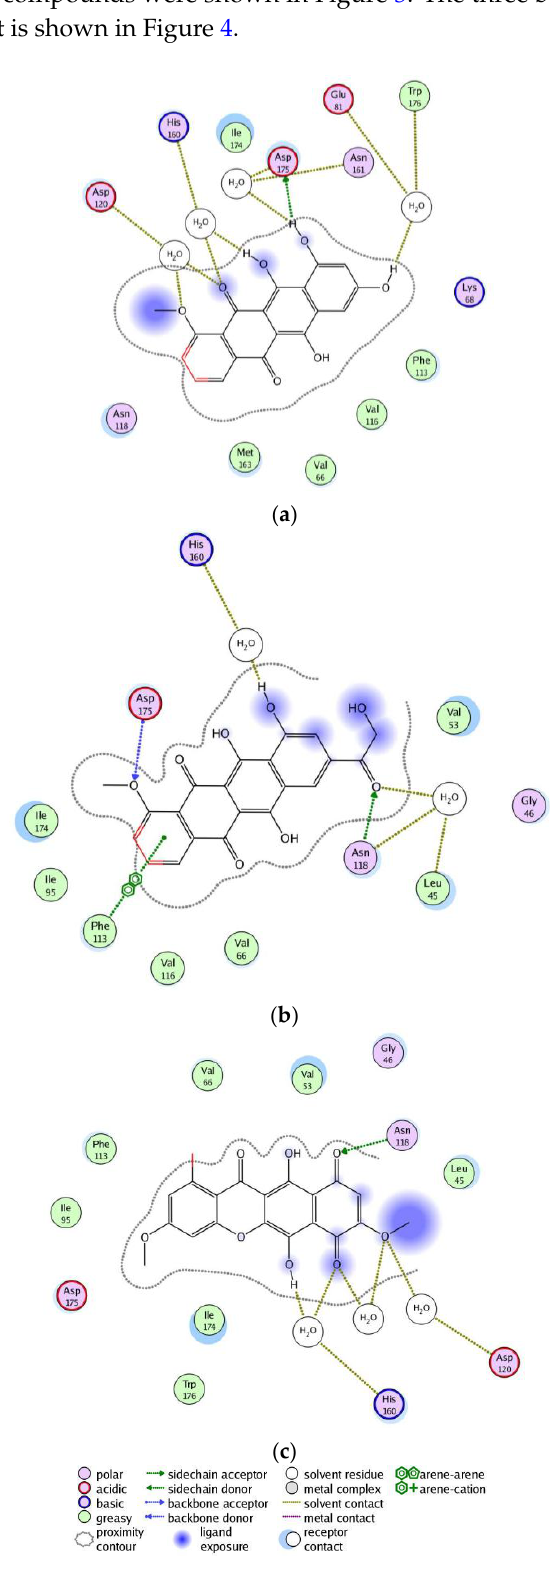
Figure 3. 2-D interactions between the three best selected compounds and the ATP binding site. ( a ) ZINC35643753; ( b ) ZINC44136135; ( c ) ZINC05765165.